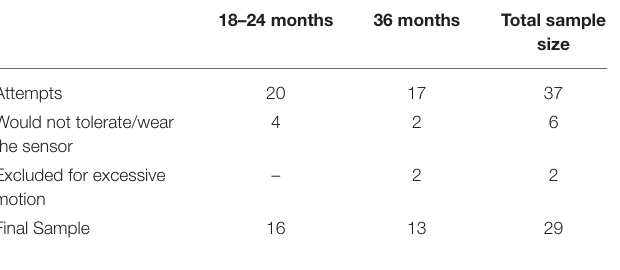
TABLE 2 | Success rates and final sample size for fNIRS data acquisition in toddlers across two age ranges (18–24 and 36 months) with varying levels of language development.